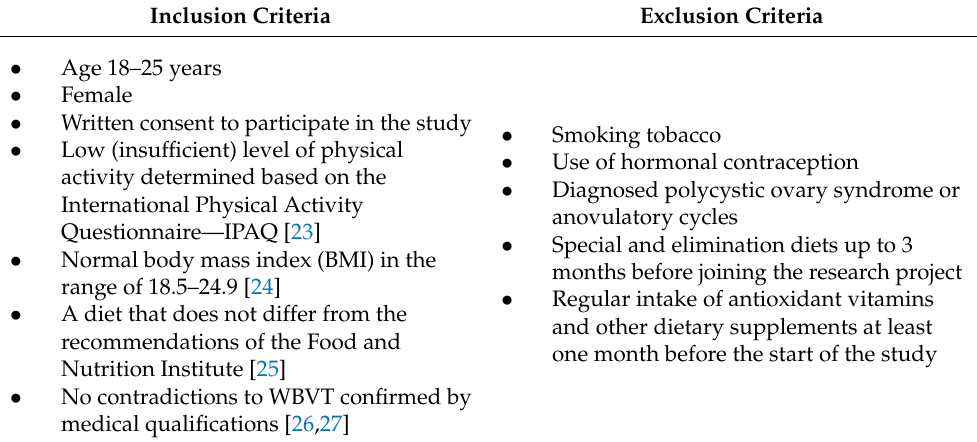
Table 1. Inclusion and exclusion criteria. Inclusion Criteria Exclusion